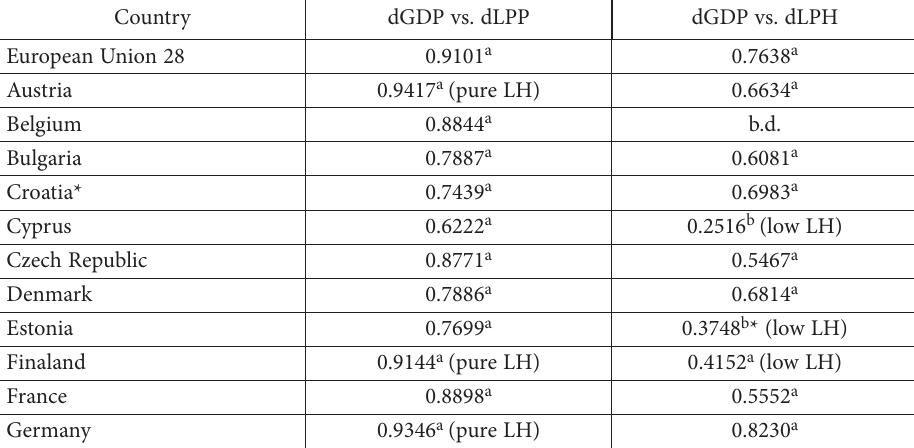
Table 1. Correlation between GDP dynamics (dGDP) and labor productivity dynamics per employee (dLPP) and labor productivity dynamics per hour of work (dLPH) in the European Union countries in